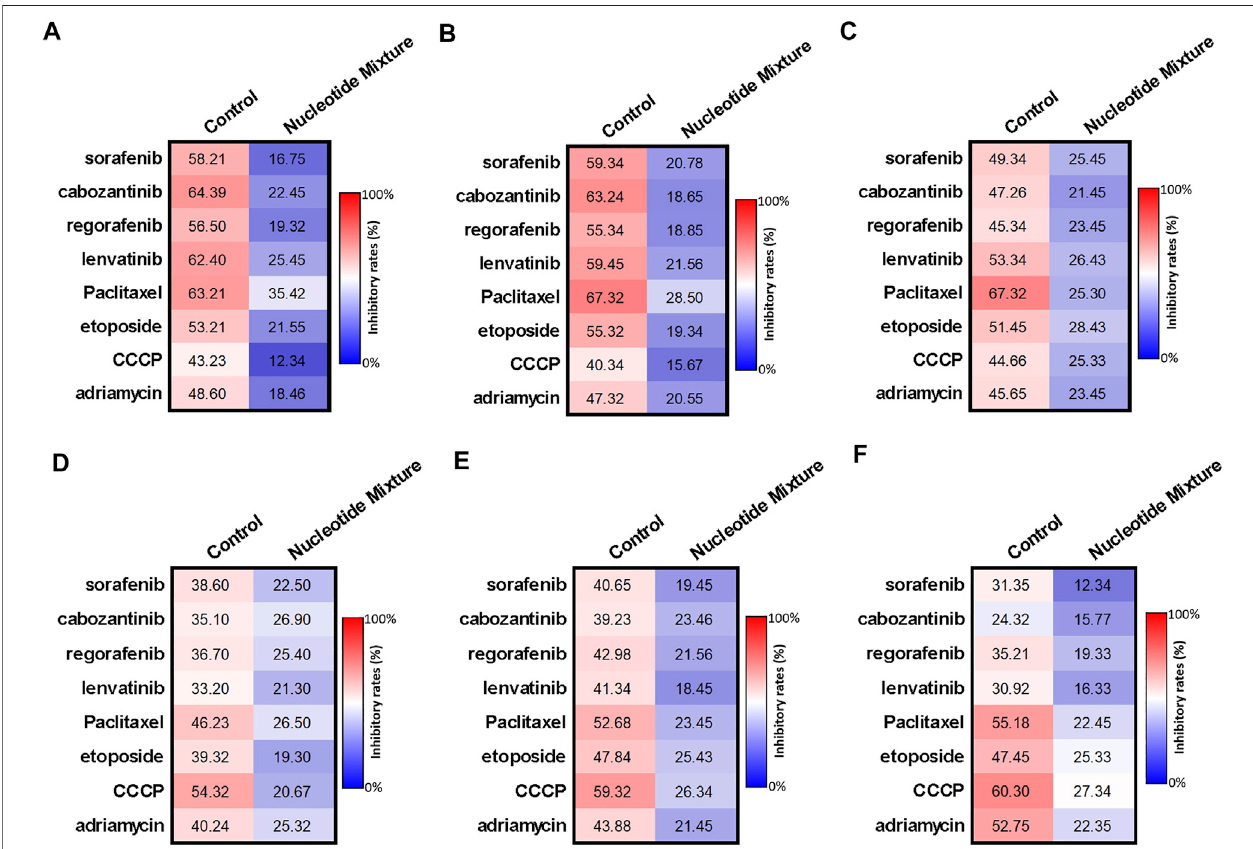
FIGURE4| ProtectiveeffectoftheSNMoncellsisolatedfromtheperipheralbloodlymphocytesofhealthyvolunteers.Peripheral-bloodlymphocyteswereisolated from blood donated from healthy volunteers. T cells (A,D) , B cells (B,E) , and NK cells (C,F) were obtained by sorting. T cells (A,D) , B cells (B,E) , or NK cells (C,F) were treatedwithimmunotoxicdrugs(sorafenib,cabozantinib,regorafenib,andlenvatinibat1 μ mol/L;paclitaxel(300 nmol/L),etoposide,(300 nmol/L),CCCP((300 nmol/L), and adriamycin (100 nmol/L) alone or in combination with the SNM. Then, the MTT assay (A – C) , or apoptosis (D – F) assay were conducted to determine the damage wrought by these drugs on T cells (A,D) , B cells (B,E) , or NK cells (C,F) . The results are shown as heatmaps.